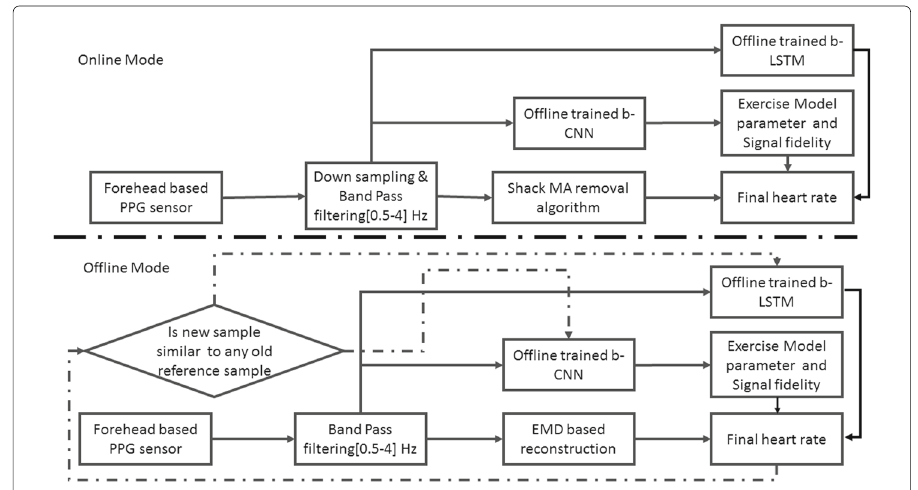
Fig. 7 Proposed heart tracking system. a The online method. b The offline mode